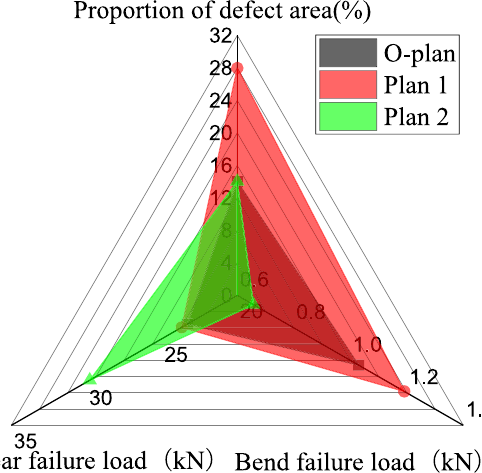
Figure 13. Finite element calculation results of various paving schemes.